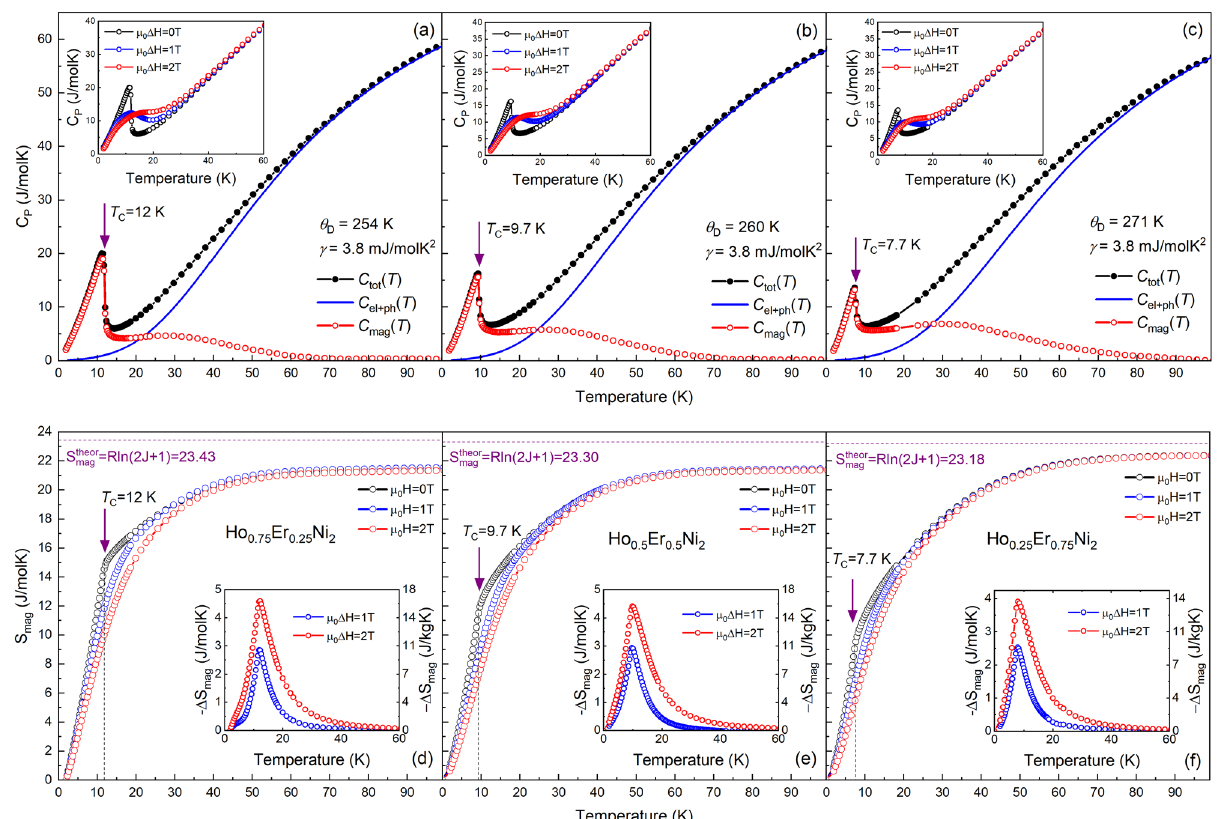
Figure 3. Total heat capacity C tot (T) of Ho 0.75 Er 0.25 Ni 2 ( a ), Ho 0.5 Er 0.5 Ni 2 ( b ) and Ho 0.25 Er 0.75 Ni 2 ( c ) measured in zero magnetic field. The calculated sum of electronic and phonon contributions C el+ph as well as estimated magnetic contribution C mag . The insets of ( a )–( c ) show the heat capacity as a function of temperature measured in zero, 1- and 2-T magnetic fields, respectively. Temperature dependences of the magnetic entropy S mag ( T ) for Ho 0.75 Er 0.25 Ni 2 ( d ), Ho 0.5 Er 0.5 Ni 2 ( e ) and Ho 0.25 Er 0.75 Ni 2 ( f ) in zero, 1- and 2-T magnetic fields. The horizontal dotted lines correspond to the theoretical maximum value S mag = R ln(2 J + 1) and the vertical dotted lines correspond to the magnetic phase transition temperature T C . Insets show the magnetic entropy change Δ S mag measured for magnetic field changes of 1 and 2